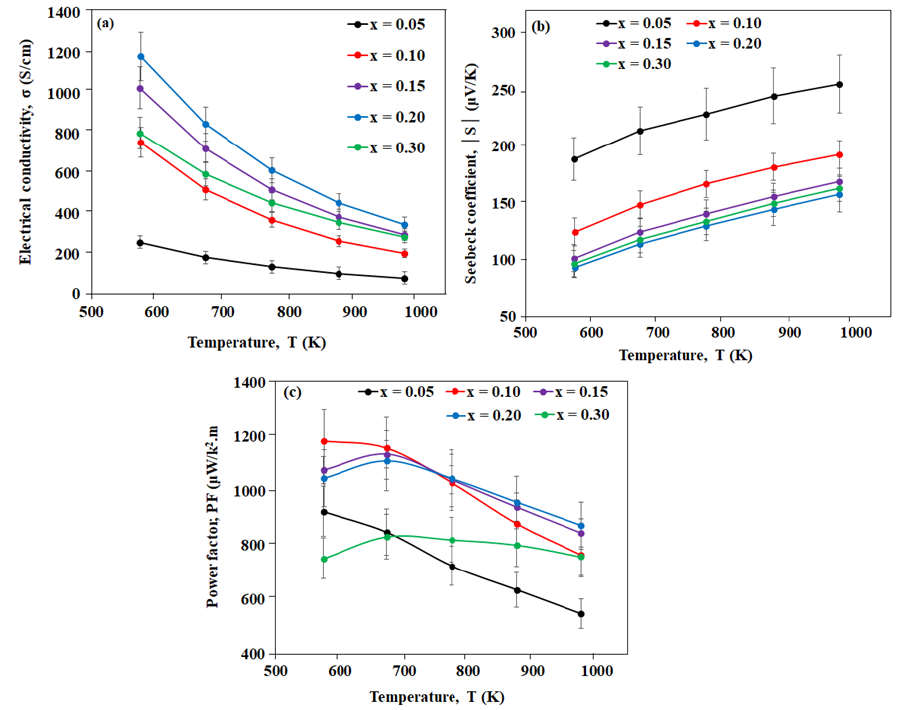
Figure 5. Temperature dependence of ( a ) electrical conductivity, σ ; ( b ) Seebeck coefficient, |S|; and ( c ) power factor, PF, for VSTO-A ceramics.